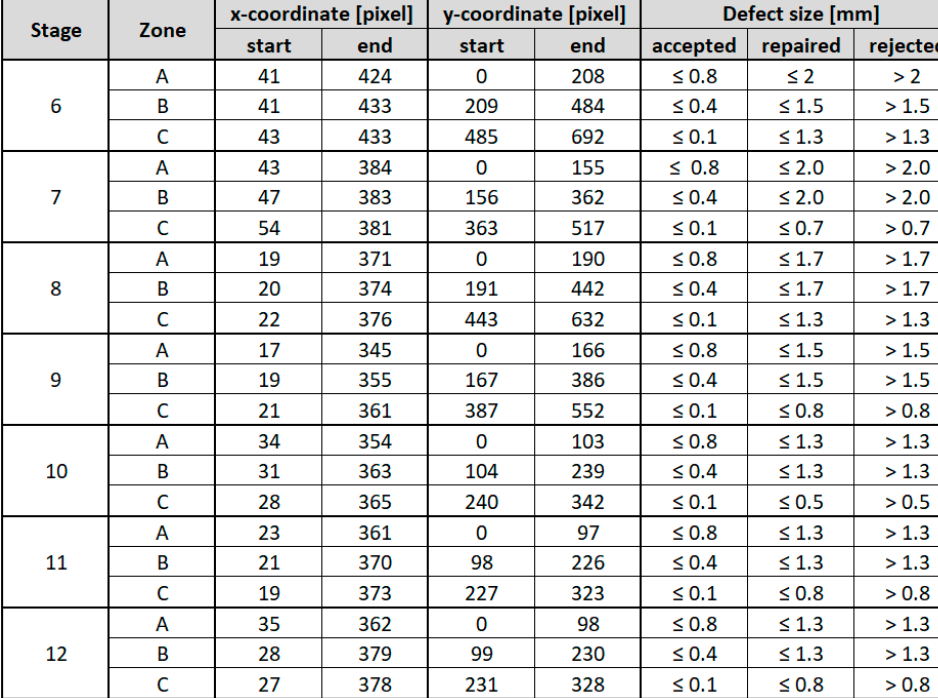
Figure 10. Blade zones and defect limits reference table.